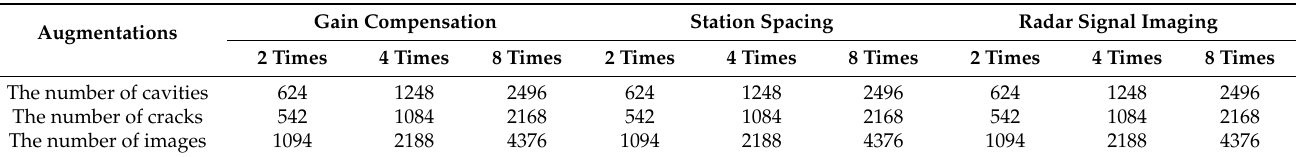
Table 3. The statistics of augmented data for